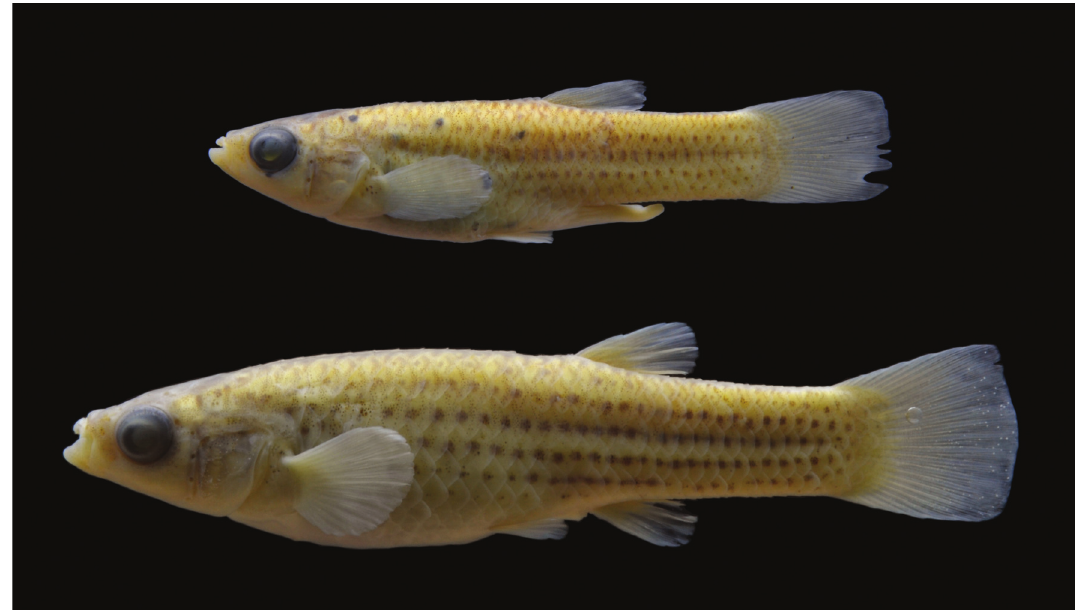
Fig. 1. Jenynsia luxata . Above: holotype CI-FML: 5464, male, 24.4 mm SL, Tucumán, Burruyacu city, a small unnamed stream, río Tajamar basin, Argentina; below: paratype CI-FML 5466, female, 34.8 mm SL, Santiago del Estero, Pellegrini, small flooded pools at Ruta Provincial 4, not connected to but near to río Urueña basin,